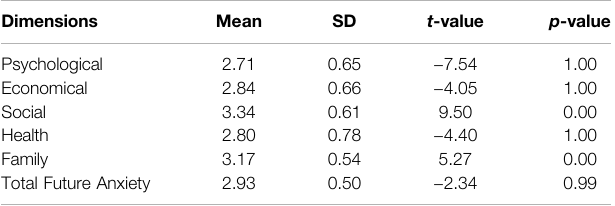
TABLE 1 | The below table shows the mean, standard deviation, and result of a one-sample t -test using different future anxiety dimensions.